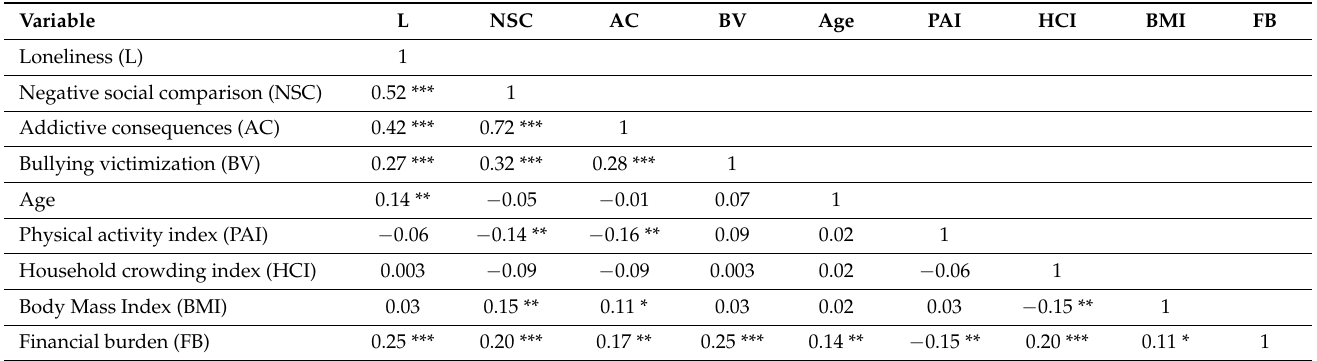
Table 2. Bivariate analysis of the continuous variables associated with loneliness.